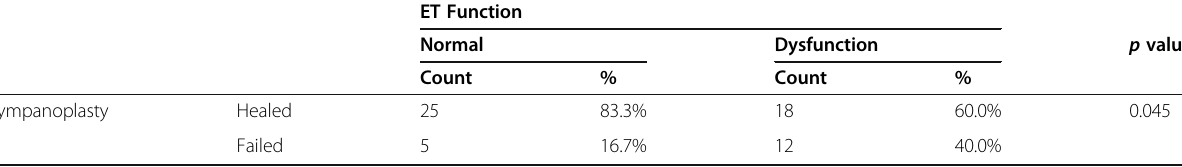
Table 1 Relation between ET function and the tympanoplasty outcome